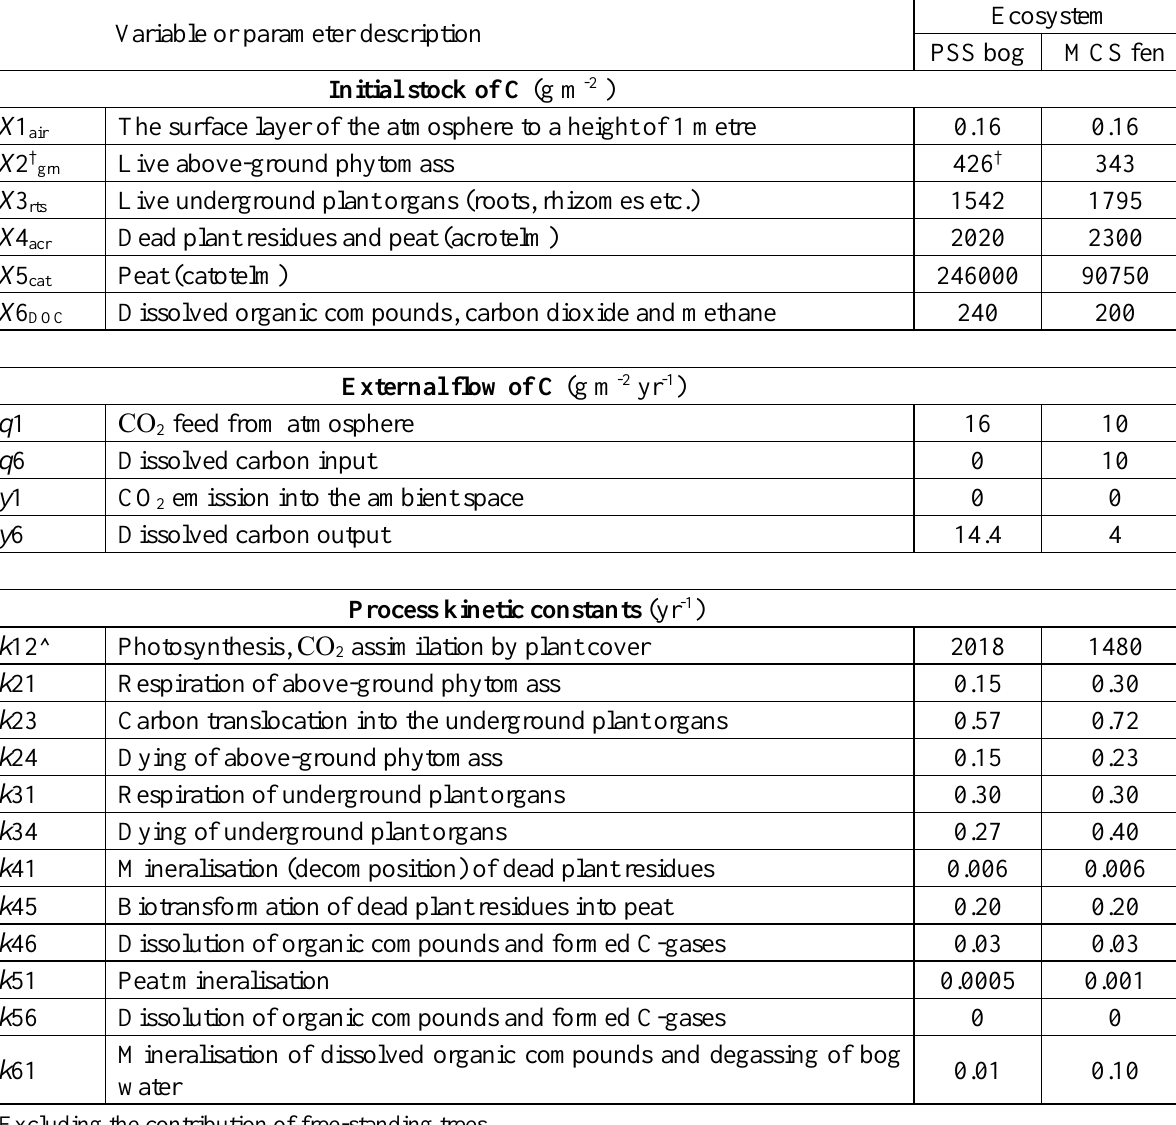
Table 1. Variables and parameters of the model for ‘Pine-dwarf shrub-sphagnum bog‘ (PSS), and ‘mesotrophic sedge-sphagnum fen’ (MCS)